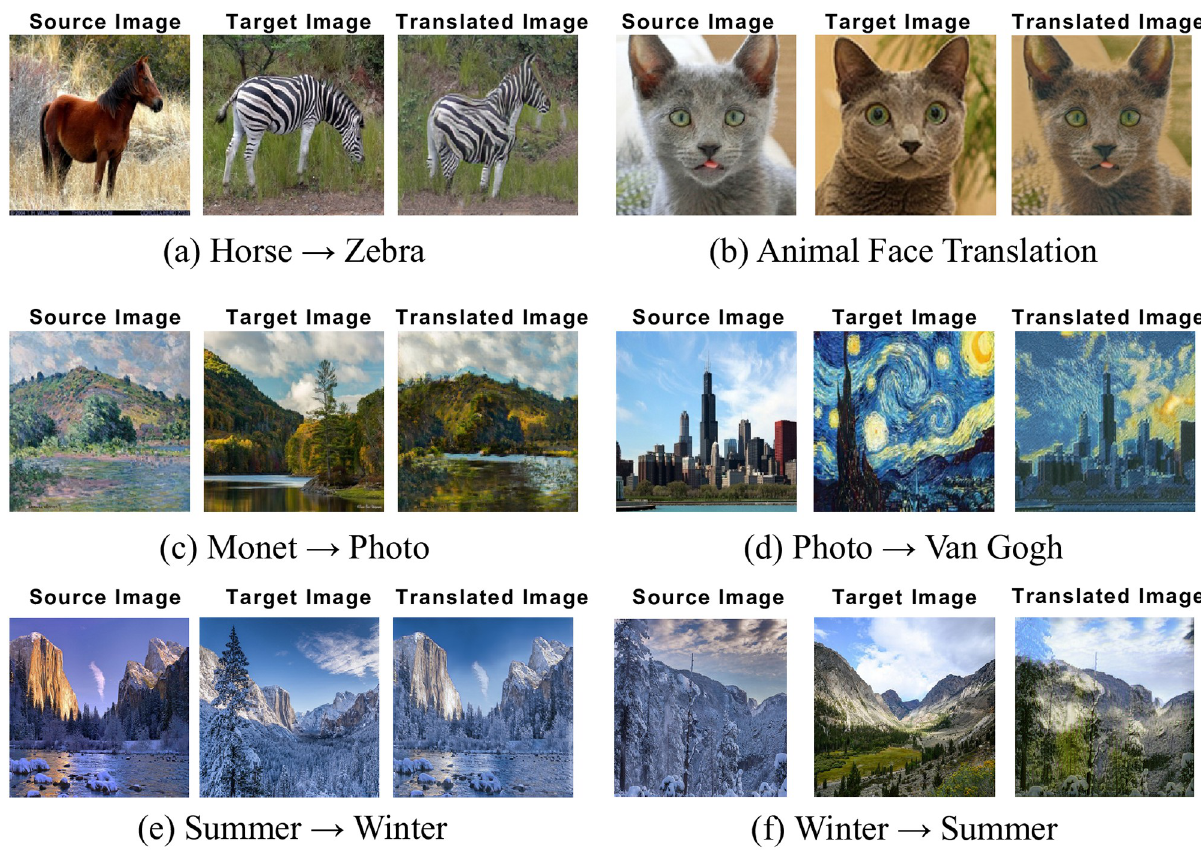
Fig 1. Several results of our proposed method on various tasks. Here we show object transformation ((a), (b)) and image style transfer((c)-(f)). The three images from left to right are the source image (which provides the main content), the target image (which provides style and high-level semantic information), and the translated